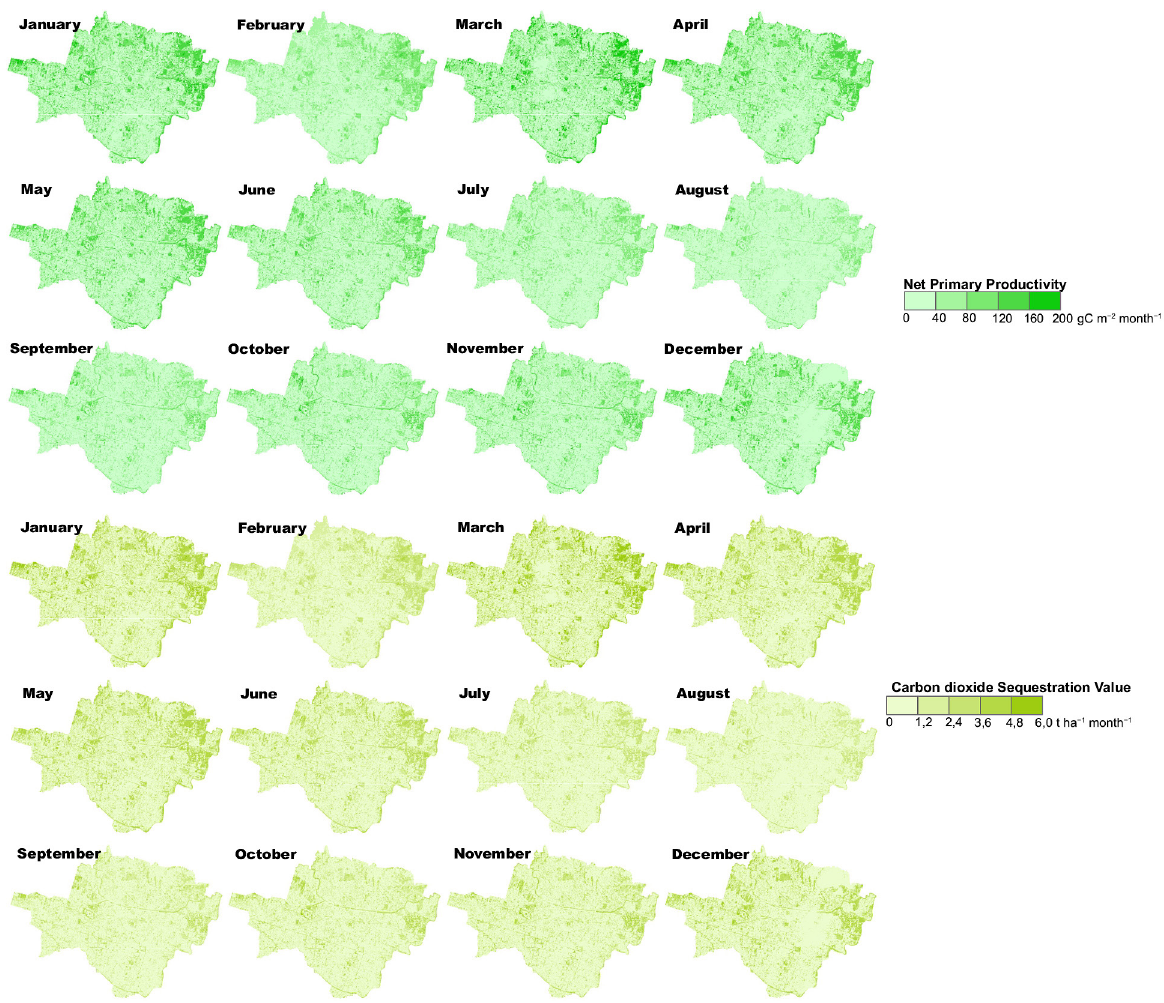
Fig. 11. Spatiotemporal maps of net primary productivity (NPP) and carbon dioxide sequestration in Surakarta